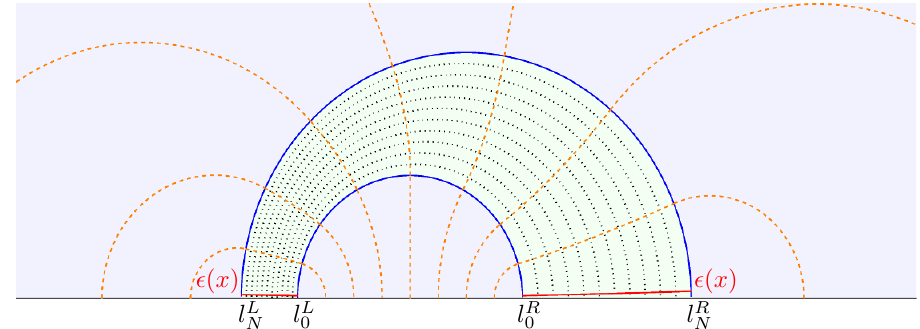
Figure 6 . A second example of a maximally packed (cid:13)ow. In this example, we have considered a family of intervals A n with variable left and right boundaries. The two limiting minimal surfaces m ( A 0 ) and m ( A N ) bound the portion of the bulk that is shaded in green. In this region, the vector V has maximal norm, i.e., j V j = 1 and is orthogonal to the intermediate minimal surfaces m ( A n ). The UV cuto(cid:11) that leaves the (cid:13)ux across the di(cid:11)erent surfaces constant is shown in red, but other choices are also allowed. The regions inside of m ( A 0 ) and outside of m ( A N ), which are shaded in blue, are continued with the geodesic (cid:13)ows constructed with the algorithm of section